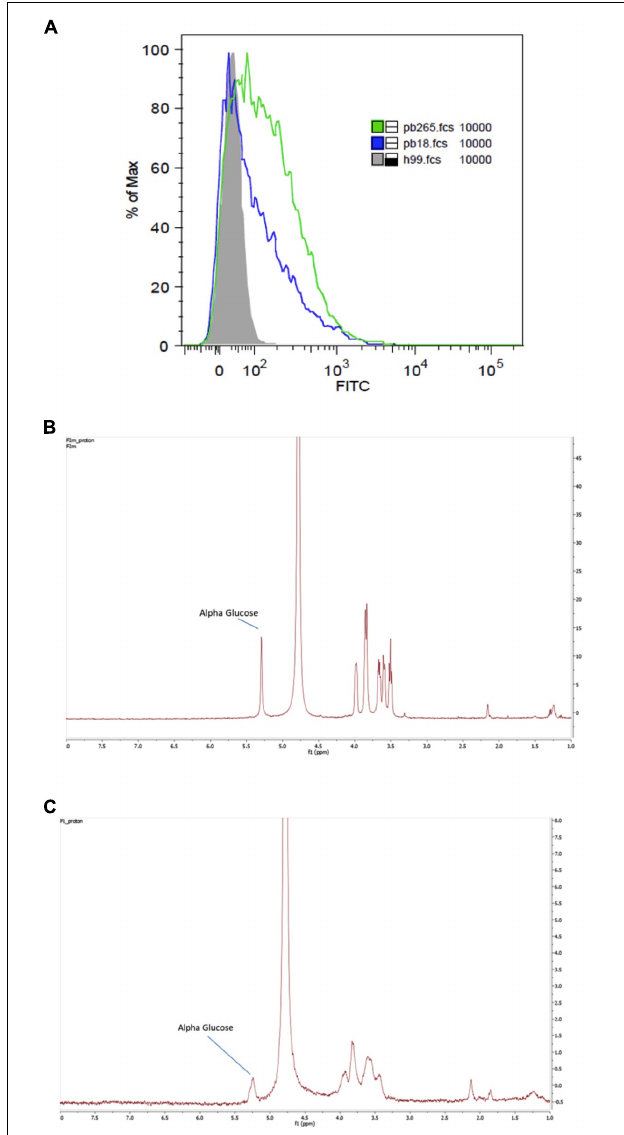
FIGURE 1 | Cell wall α -glucan correlates to decrease in β -glucan exposure in Paracoccidioides brasiliensis . Exposure of β -glucan in the cell wall of P. brasiliensis virulent (Pb18) and avirulent (Pb265) isolates and Cryptococcus neoformans (H99) (A) . NMR spectroscopy of F2 (B) and F1 (C) cell wall fractions.